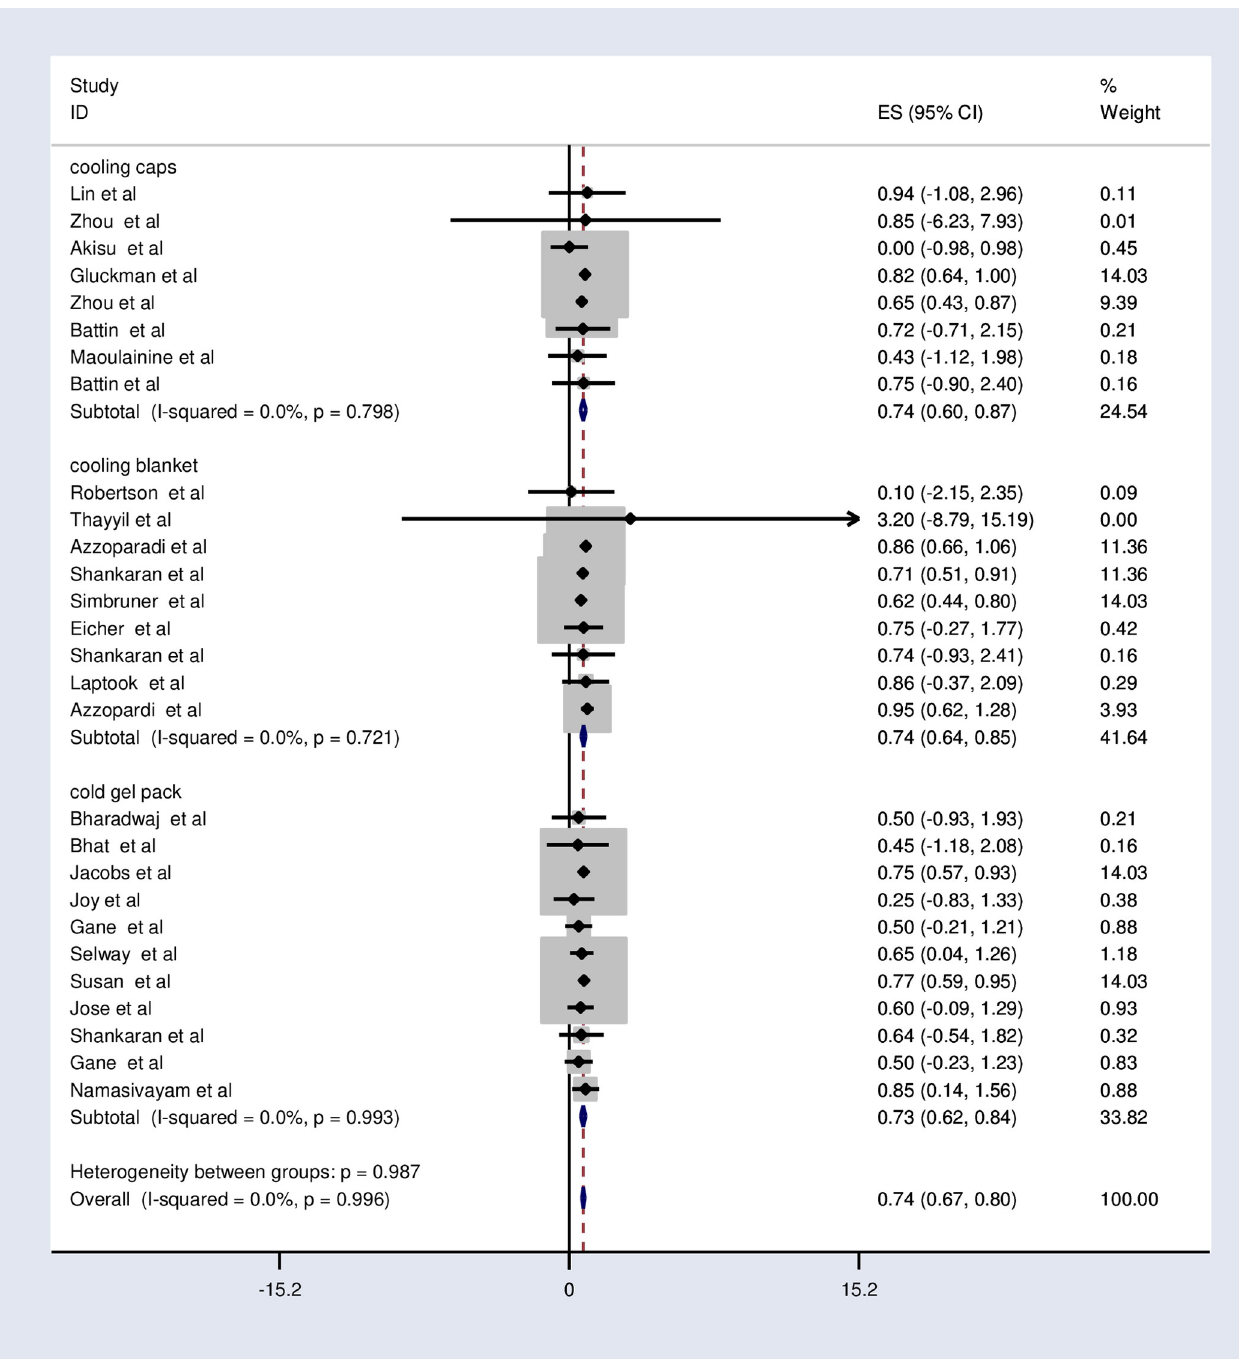
Fig 5. Subgroup analysis by the device of cooling effects of therapeutic hypothermia on death among asphyxiated neonates with hypoxic-ischemic encephalopathy.